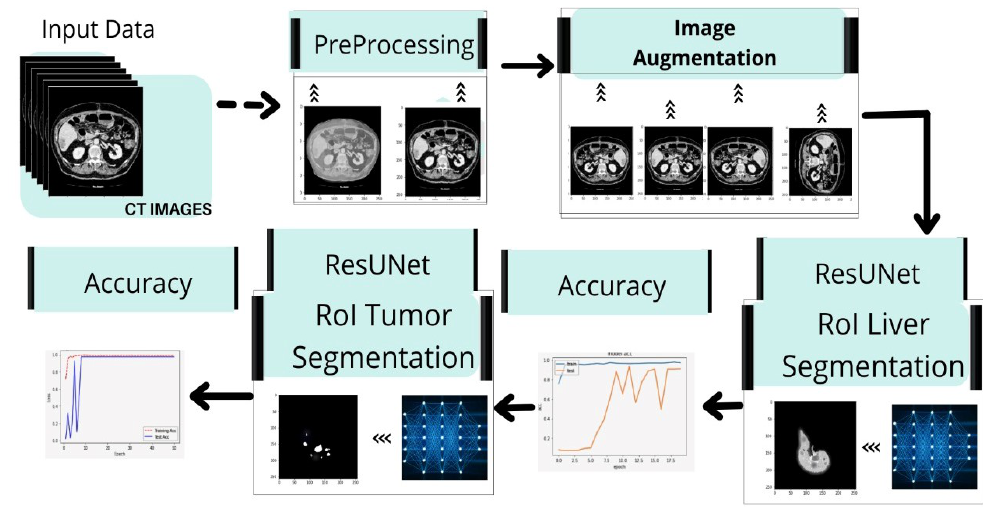
Figure 15. Implementation framework of deep learning neural network on liver and liver tumor seg-